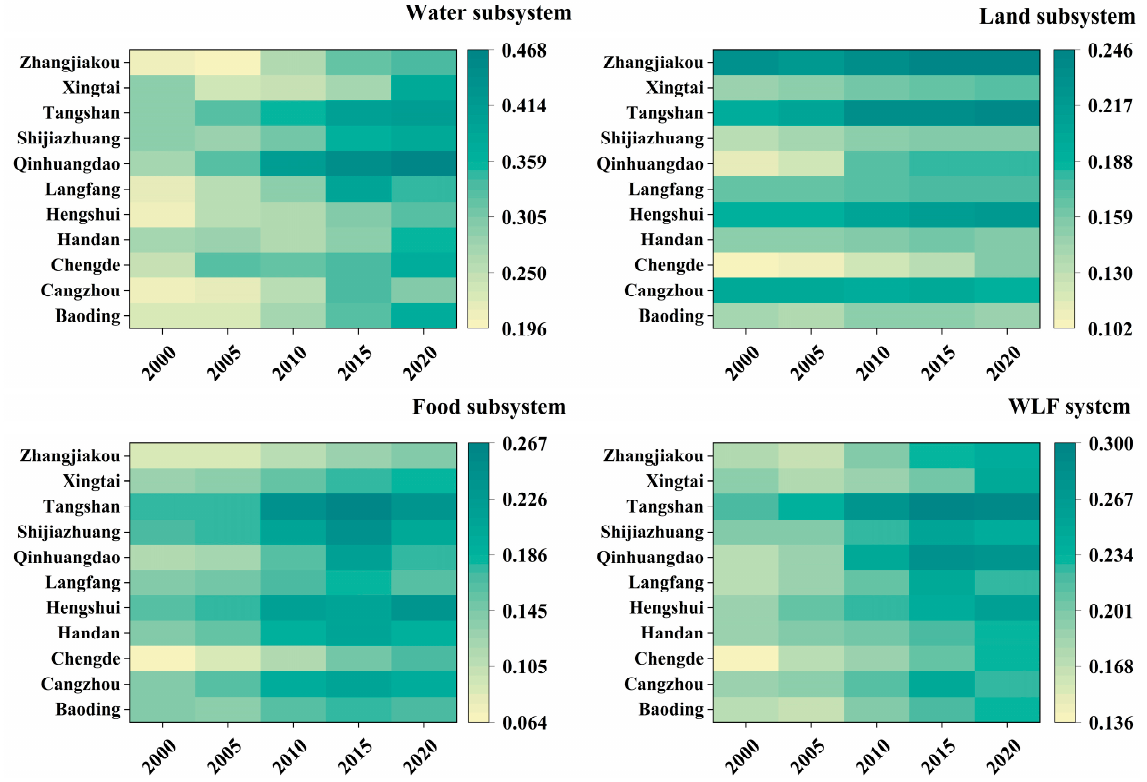
Figure 2. Evolutionary trends in the comprehensive evaluation indices for each subsystem and WLF system in 11 cities in Hebei Province from 2000, 2005, 2010, 2015, and 2020.